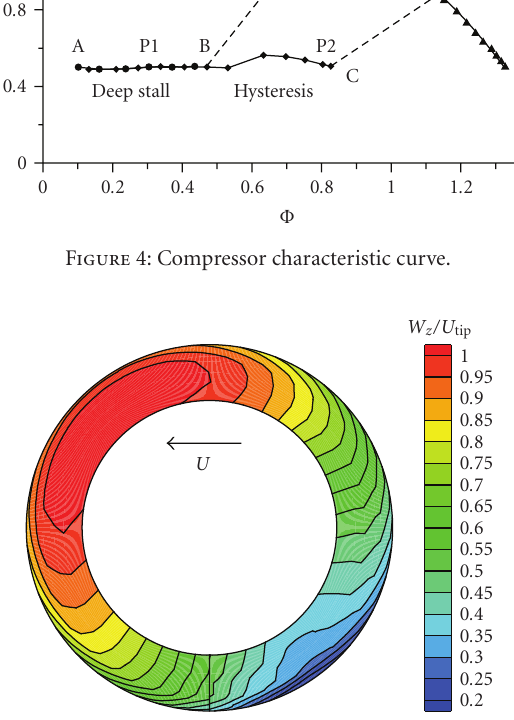
Figure 5: Axial flow component section